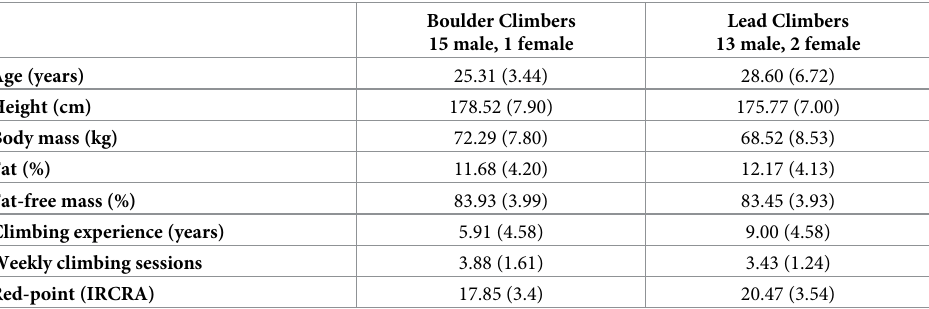
Table 1. Anthropometric data, number of weekly climbing sessions, climbing experience and self-reported climb- ing ability (IRCRA scale). Data are given as mean ( ±